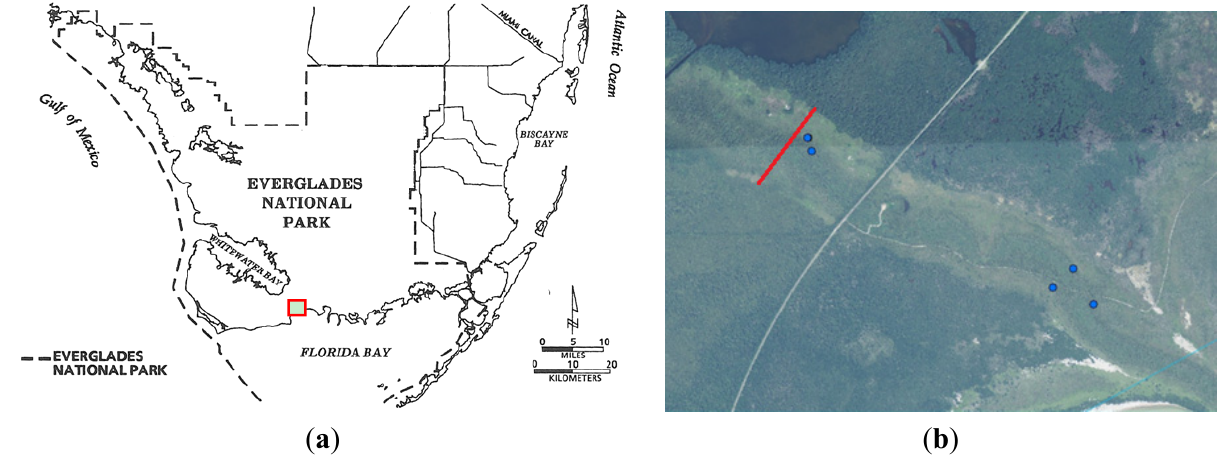
Figure 2. ( a , Left ) Southern Florida with site shown in red box (from Light and Dineen 1994 [23]). ( b , Right ) Aerial view of Coot Bay Hammock, with 370 m transect, shown in red. Blue dots indicate well sites. l. (Figure 2a adapted from reference [23] with copyright permission).